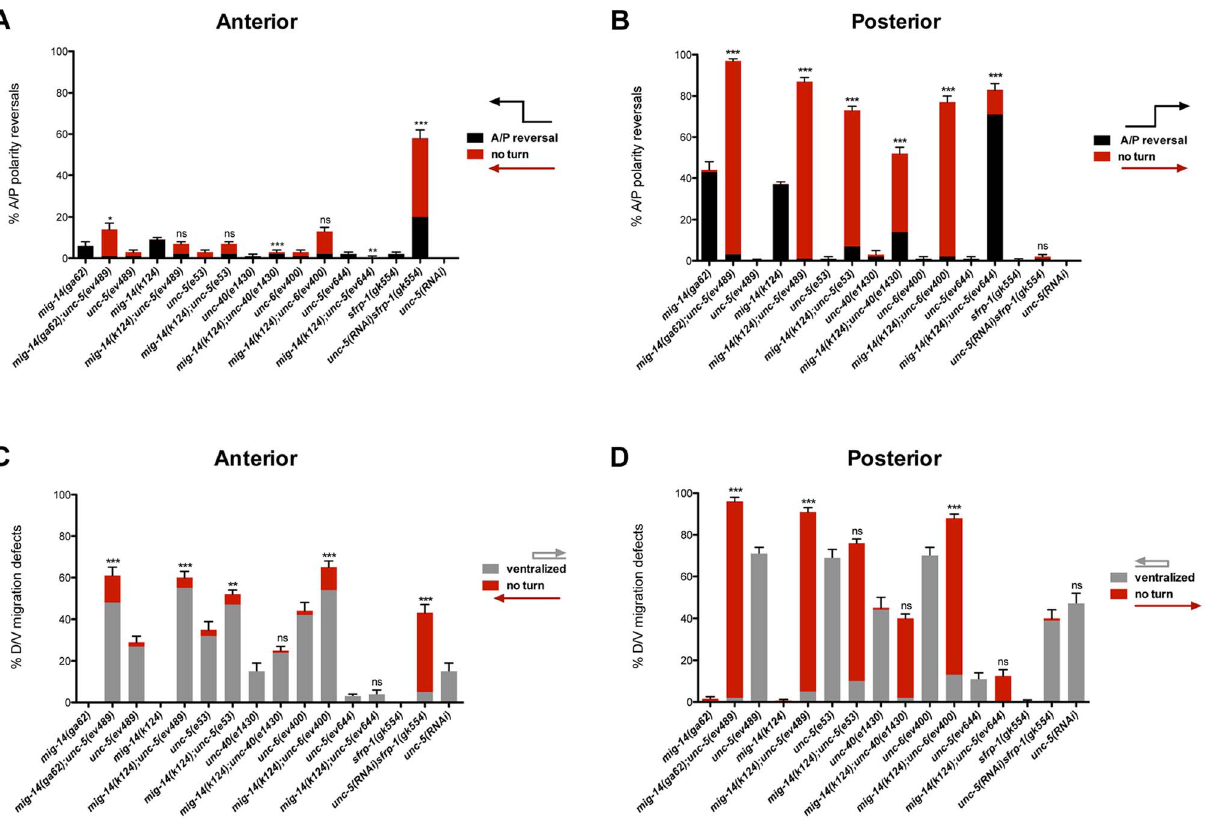
Figure 2. Netrin signaling and mig-14/wntless have redundant roles in A/P and D/V guidance of the DTCs. (A, B) Quantification of phase 3 A/P polarity reversals in single mutants of mig-14/wntless , unc-5 , unc-40 , unc-6 and sfrp-1 versus double mutants of mig-14 with unc-5 , unc-40 , or unc-6 and of sfrp-1 with unc-5(RNAi) . Bars represent the percentage of phase 3 polarity reversals (black) and ‘no turn’ (red) phenotypes. The latter represent a subset of the phase 3 reversals. The corresponding raw data for all panels are presented in Table S2. All strains were analyzed in the background of dnIs31[gly-18p::gfp] to visualize the DTCs. mig-14(ga62); unc-5(ev489) was also analyzed without gly-18p::gfp , which made no difference (Table S2). Most of the progeny of the mig-14(k124); unc-6(ev400) double mutant were not viable, therefore, escapers were analyzed. Error bars indicate standard error of the sample proportion. Comparisons of the total phase 3 A/P reversals for double deficits were made to mig-14(ga62) , mig- 14(k124) , or sfrp-1(gk554) . ***P , 0.00001 **P , 0.001; *P , 0.05; ns=not significant (P $ 0.05). (C, D) Quantification of the phase 2 D/V migration failures in the strains presented in panels (A) and (B), respectively. Bars represent the percentage of ‘ventralized’ (grey) and ‘no turn’ (red) gonad arms. The latter represent a subset of the phase 2 migration failures. The corresponding raw data for all panels are presented in Table S2. Error bars indicate standard error of the sample proportion. Comparisons of the total phase 2 migration failures (‘no turn’ plus ‘ventralized’ gonad arms) were made between paired single and double deficits. ***P , 0.00001 **P , 0.001; *P , 0.05; ns=not